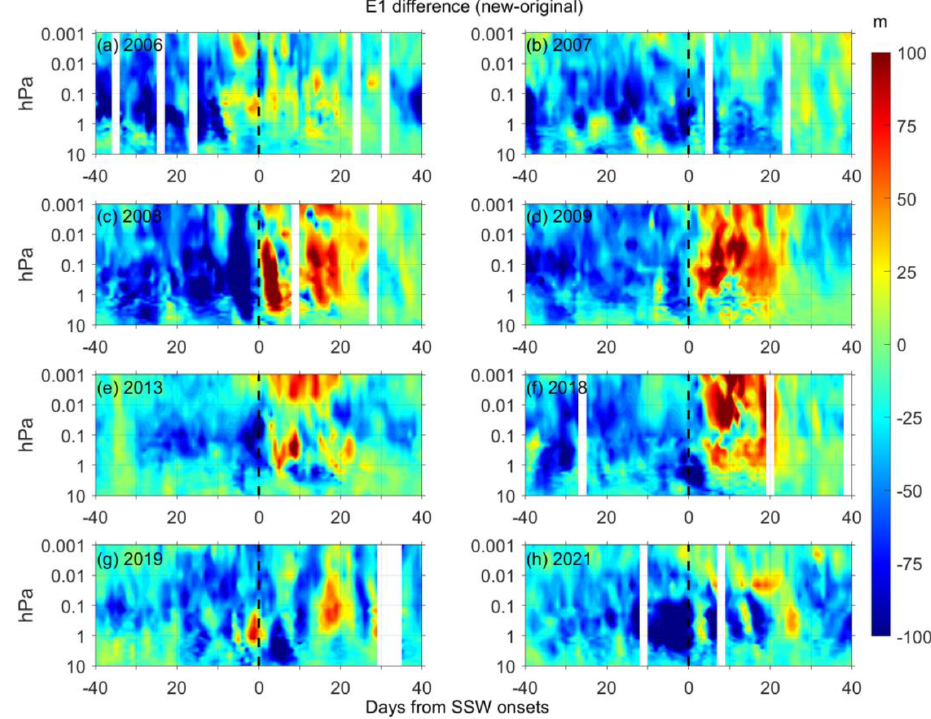
Figure 8. Same as Fig. 6 but for the E1 component.